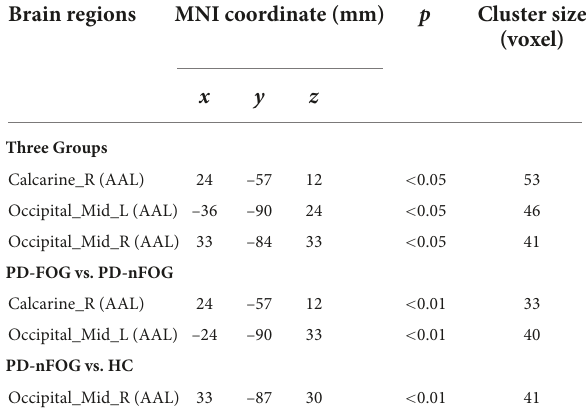
TABLE 2 Comparison of functional connectivity between PD-FOG, PD-nFOG, and HC group.